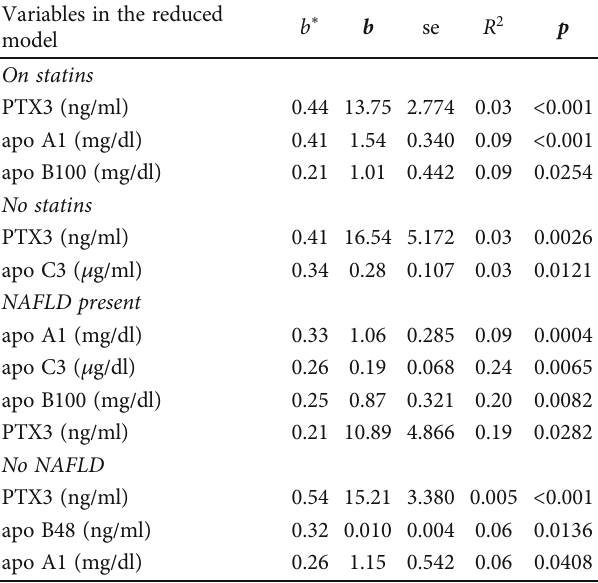
Table 6: Results of multiple backward stepwise regression analysis with PCSK9 as dependent variable in group of patients according to statin treatment and according to presence of